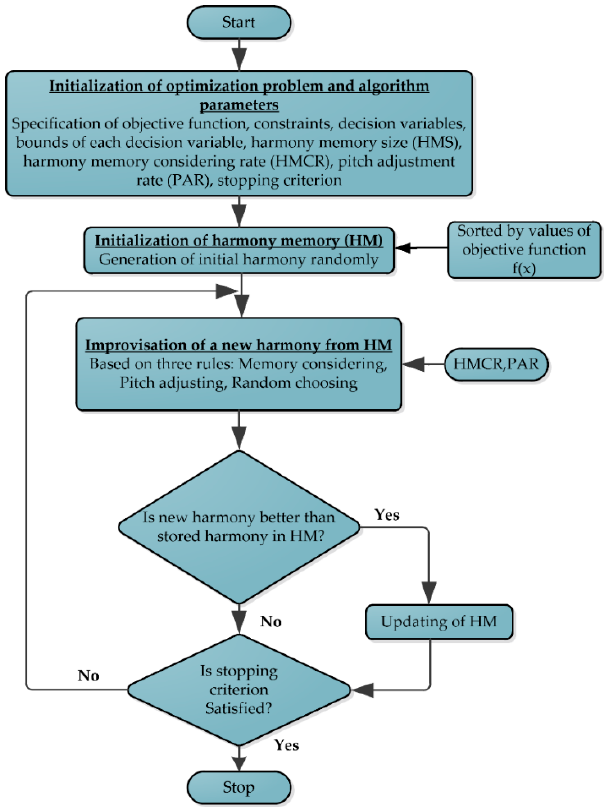
Figure 1. Flow diagram of the Harmony Search Algorithm (HSA).